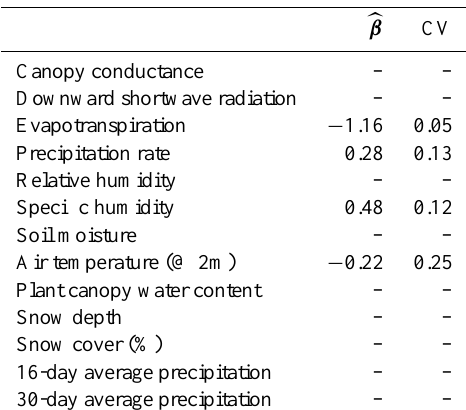
Table 2. Candidate NARR environmental covariates, with associ- ated b β values for those variables selected using BIC for inclusion in the NARR inversion with the EMP boundary conditions. Auxil- iary variables were normalized to zero mean and unit variance, such that b β values are directly comparable. Variables with dashes (“–”) were considered but not selected by the BIC/ Branch & Bound al- gorithm. Also shown are the coefficients of variation (CV) for the